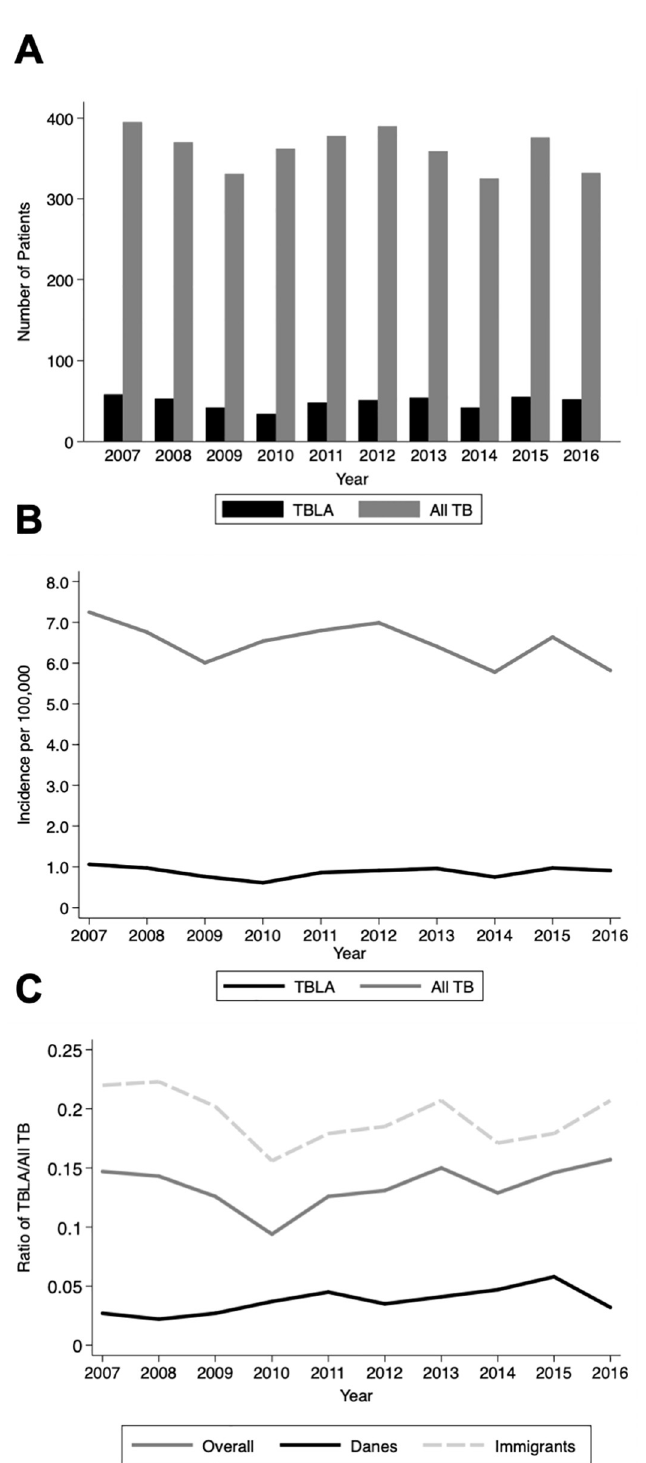
Fig 2. Incidence of tuberculous lymphadenitis. A) Number of patients notified with tuberculous lymphadenitis (TBLA) and all notified tuberculosis (TB) cases in the national TB register from 2007 through 2016, B) Corresponding incidence rates per 100,000 citizens and C) Overall ratio of TBLA/all TB and for immigrants and Danes respectively.